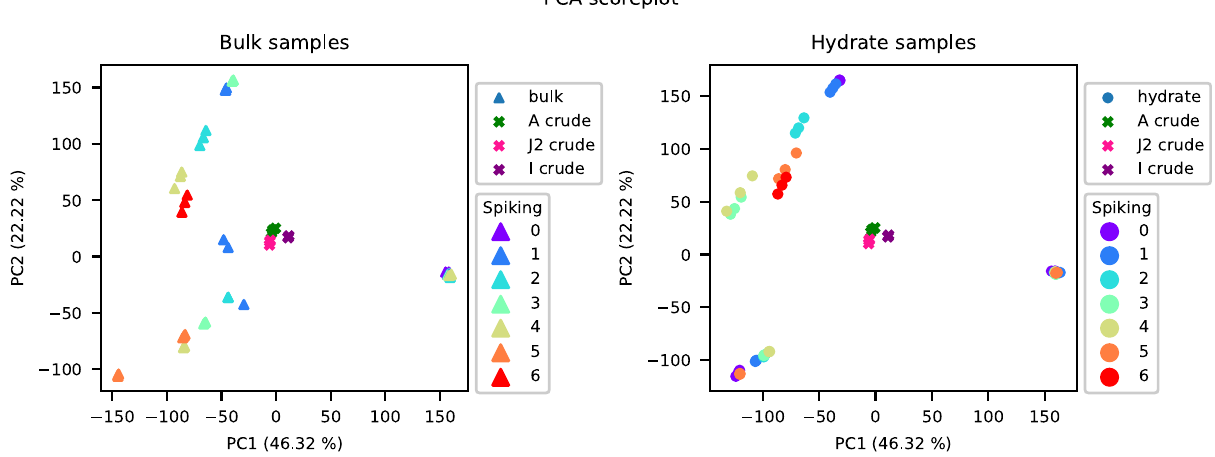
Fig 3. PCA scoreplots with samples from the bulk phase shown in the left plot and samples from the hydrate phase shown in the right plot. Samples are coloured by spiking level and the crude oils have the symbol x.